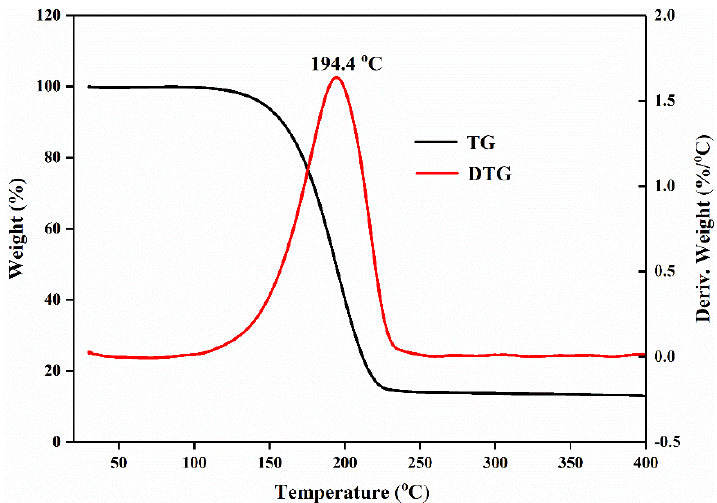
Figure 6. The CA–MA/EG thermal conductivity variations with the packing density.